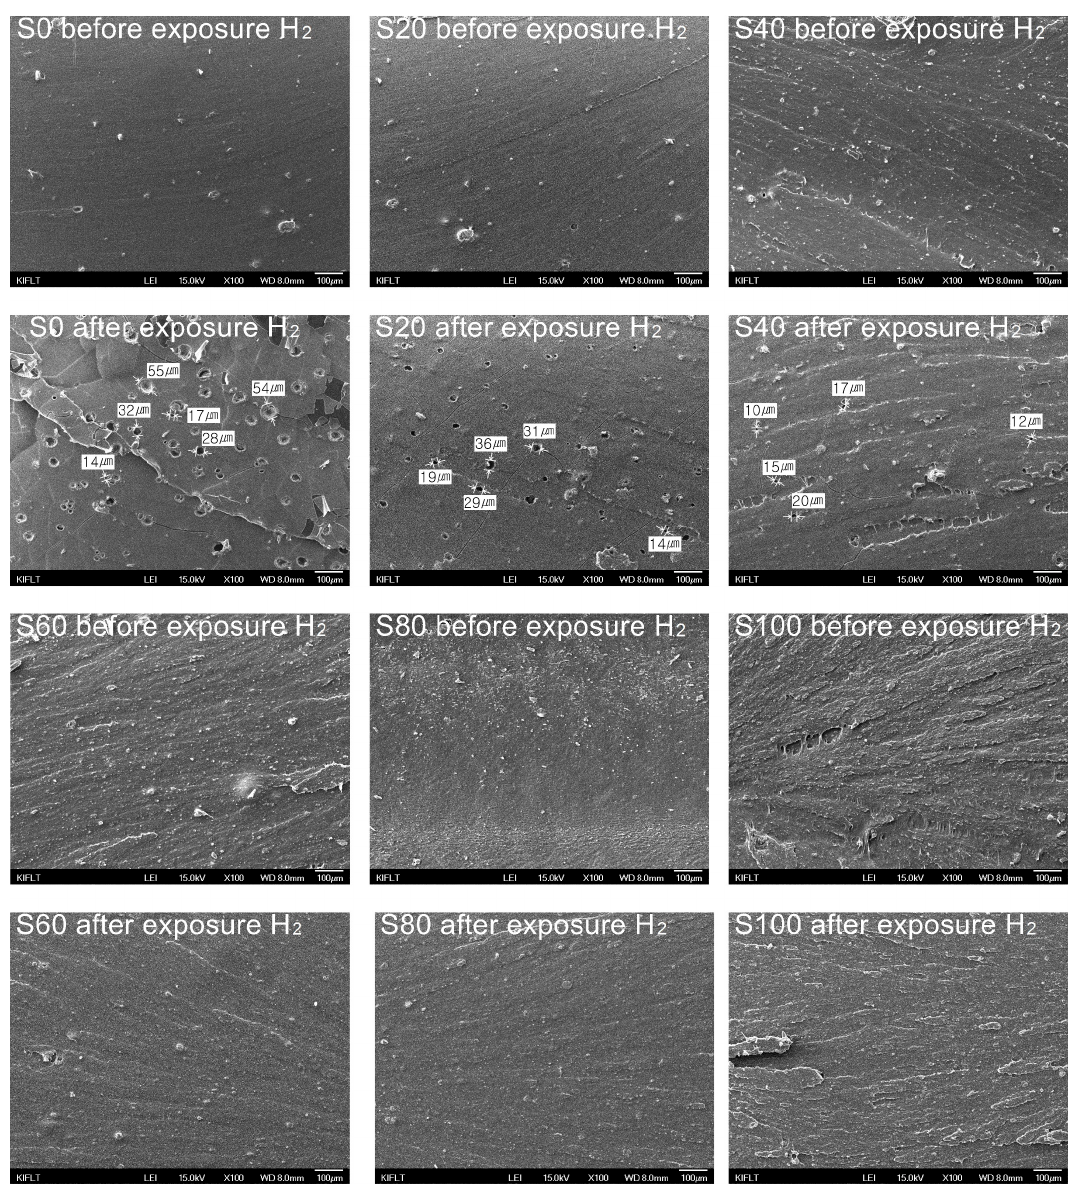
Figure 9. SEM images of the fracture surfaces of EPDM/silica vulcanizates before and after exposure to 96.3 MPa of hydrogen gas (H 2